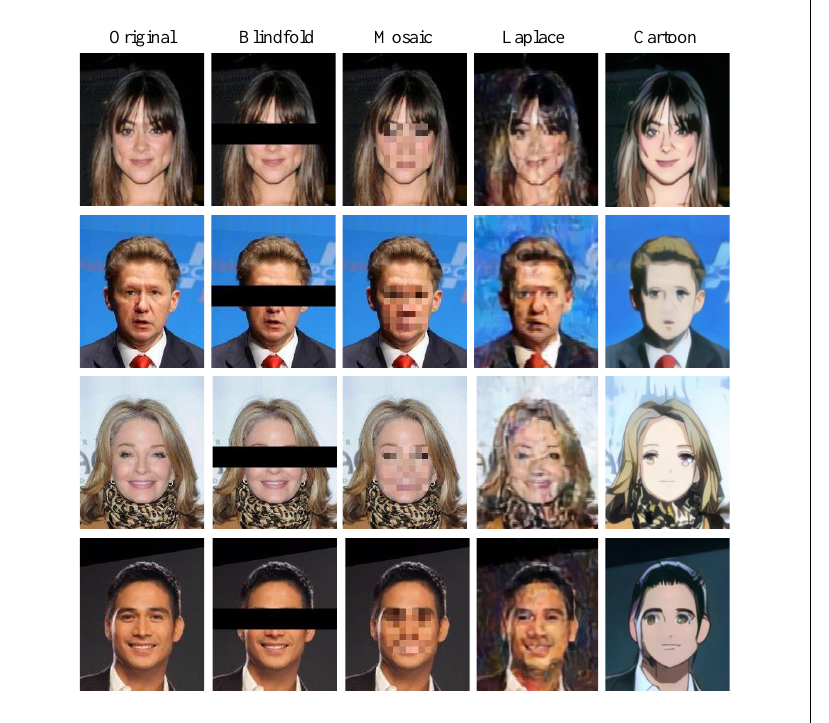
Figure 5. The results of the de-identified image. Table 2. Service quality loss rate under the four de-identification modes. Type